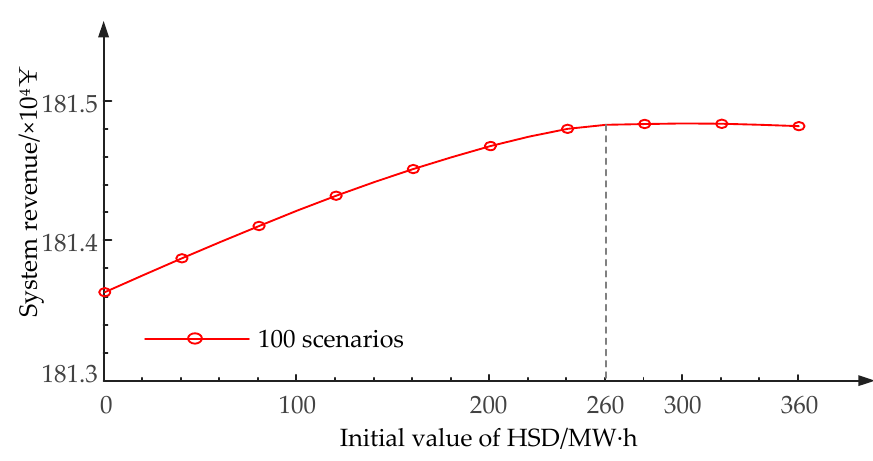
Figure 8. The system revenue under different initial heat storage capacity.